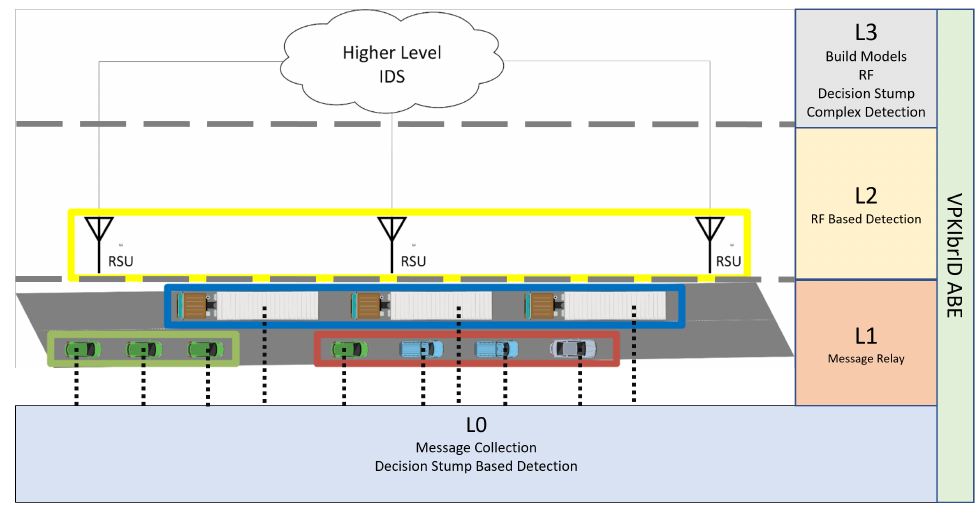
Figure 10. Intelligent Hierarchical IDS Security Framework—A platooning